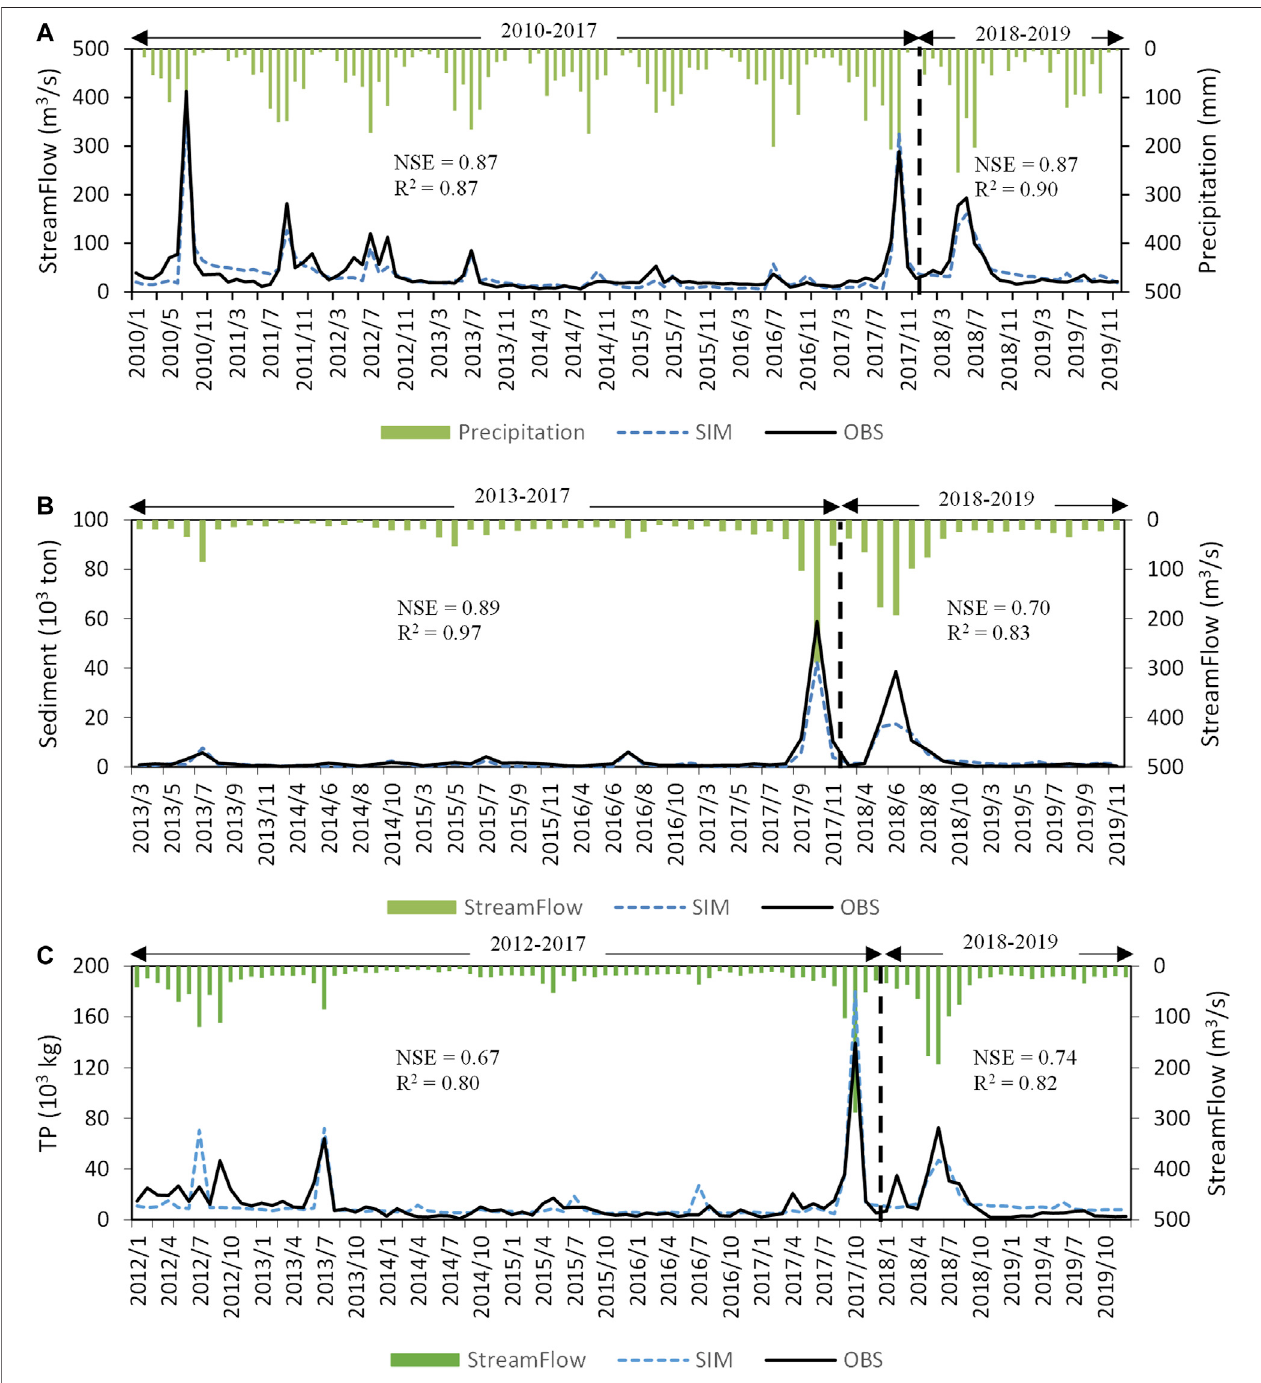
FIGURE3| Comparison ofthesimulated andobservedstream fl ow,sediment, andTPloadsat theBaihe riverbasin(Dotted linesegmentcalibrationandvalidation period).